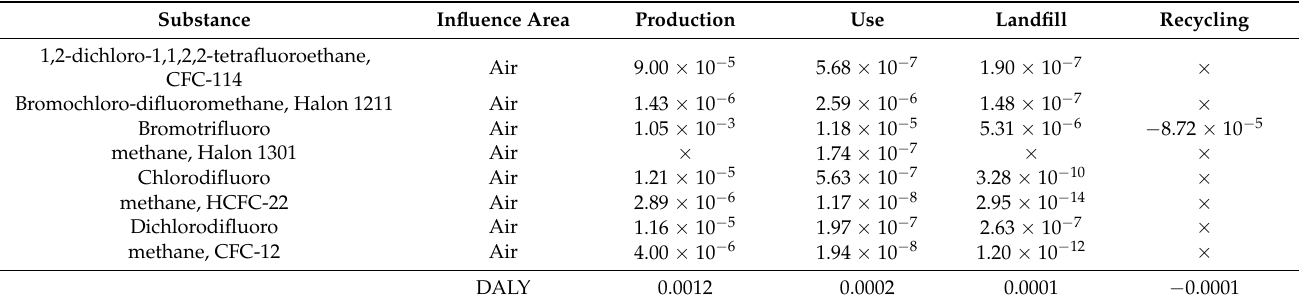
Table 7. The results of studies characterizing the environmental consequences for compounds that deplete the ozone layer, occurring at different stages of the life cycle of the Vestas V90, DALY [own